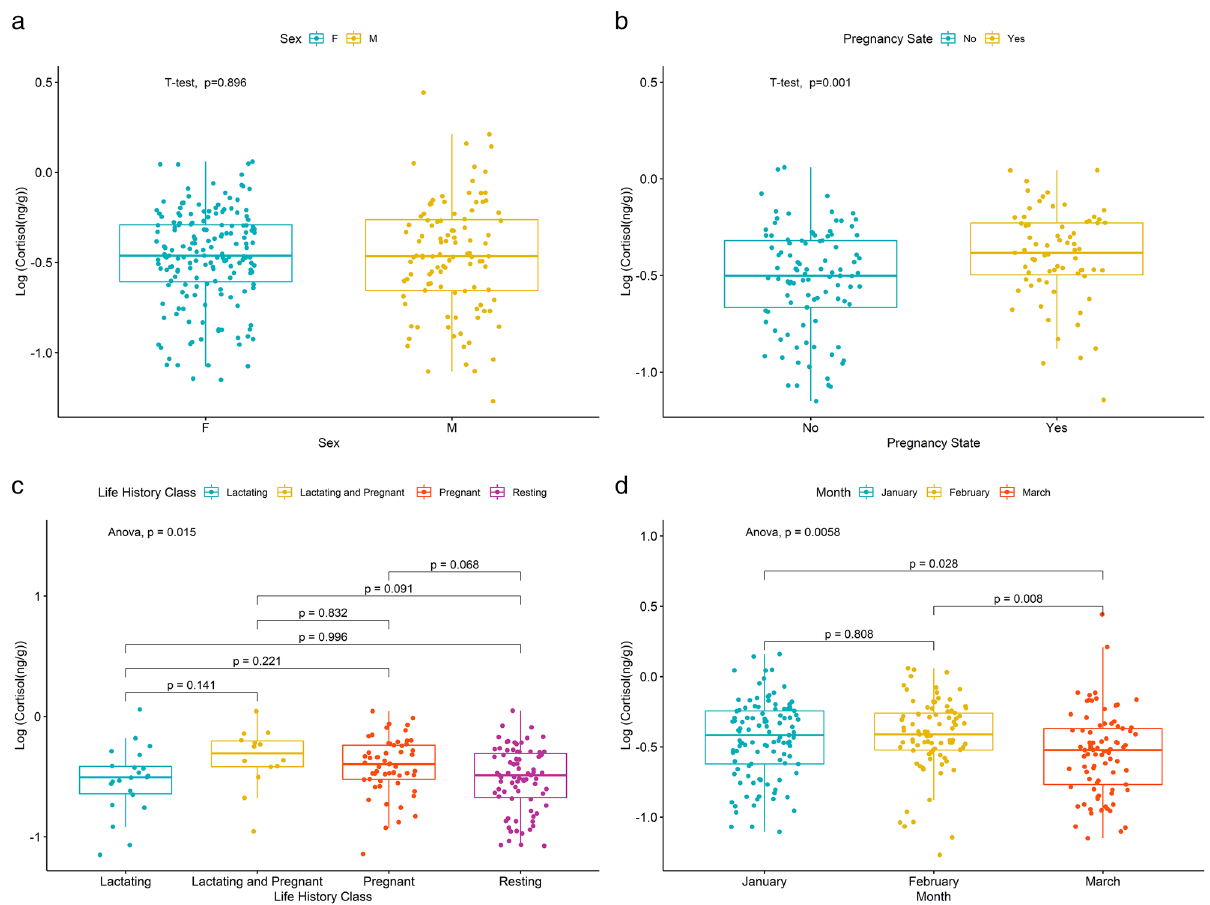
Figure 3. Blubber cortisol concentrations (ng/g wet weight) of humpback whales sampled along the Western Antarctic Peninsula during 2019–20. Blubber cortisol concentrations by sex ( a ), pregnancy state ( b ), life history class ( c ), and across months ( d